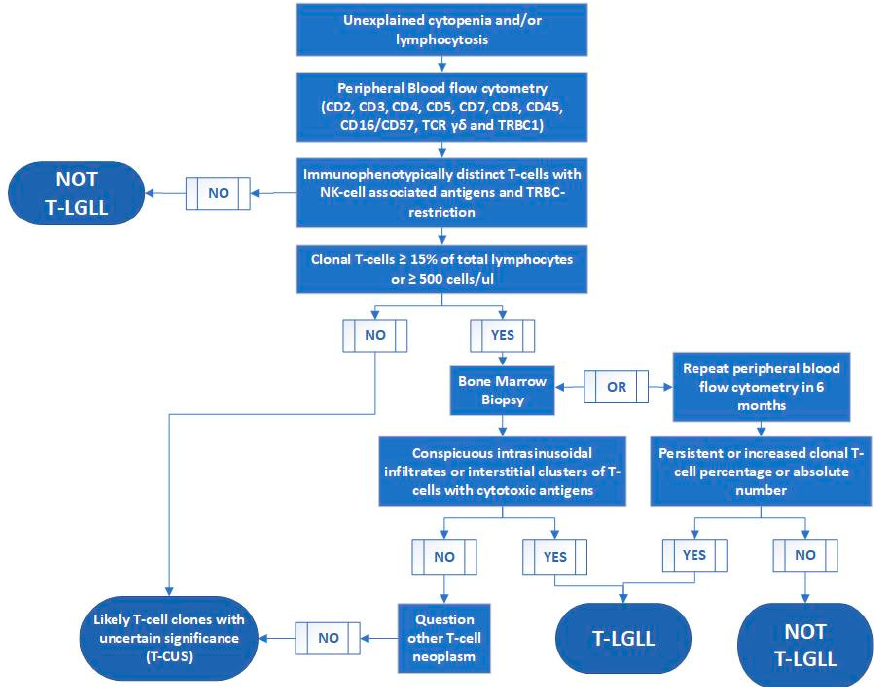
Figure 4. Laboratory work-up of patients with clinical suspicion for T-cell large granular lymphocytic leukemia (T-LGLL).